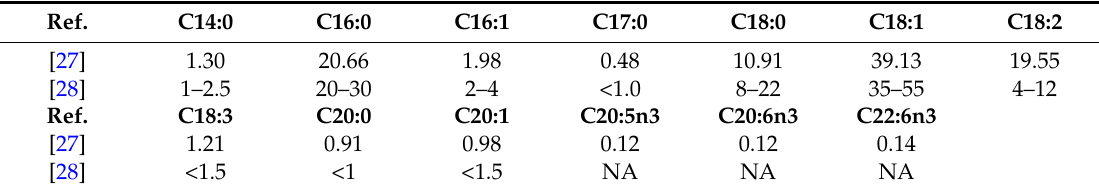
Table 1. Fatty acid (FA) composition of waste pig fat.